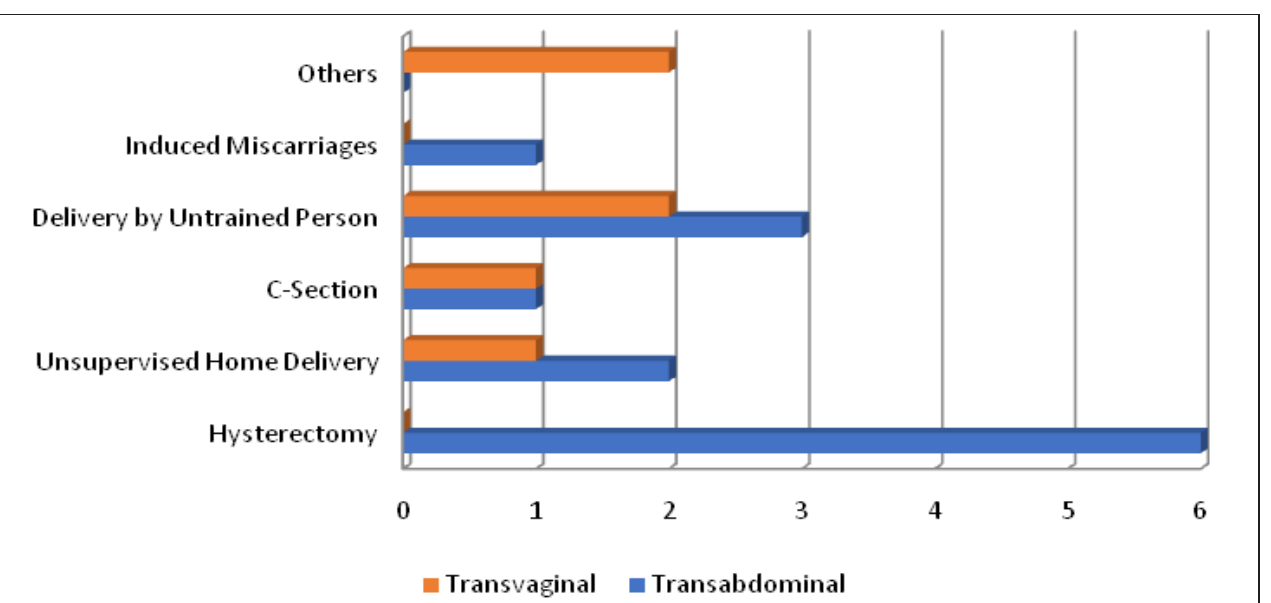
Figure-II: Risk factor for fistula development in study